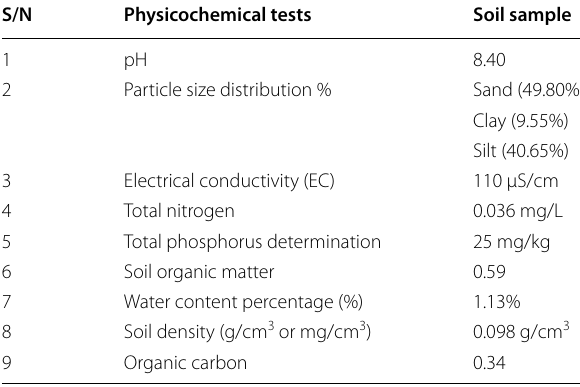
Table 1 Physico-chemical values of pre-solarized